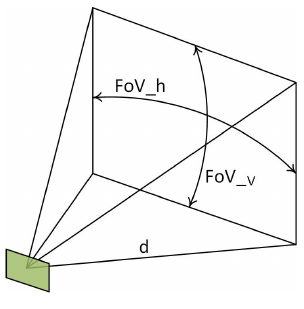
Figure 1. FoV characteristics.